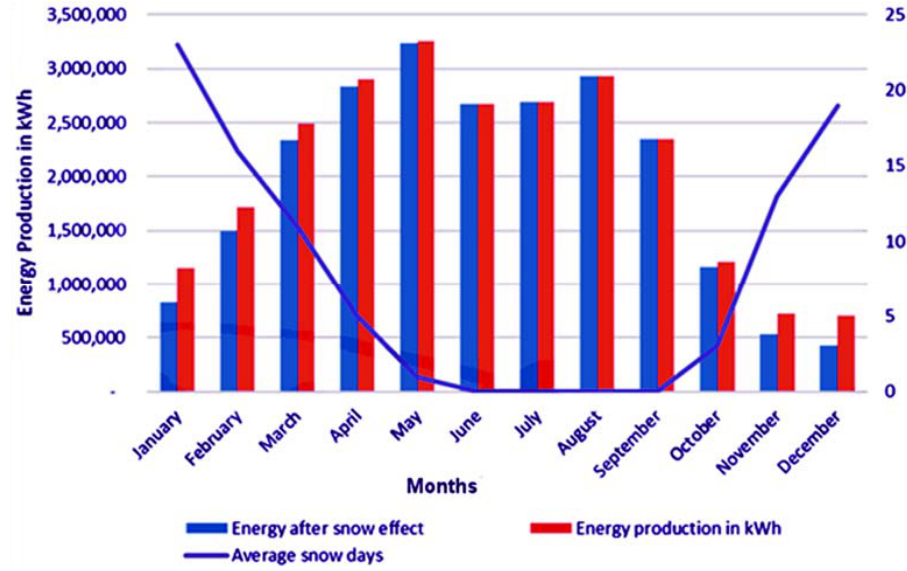
Figure 5. Monthly energy production with production with snow losses based on the configuration of solar system. solar